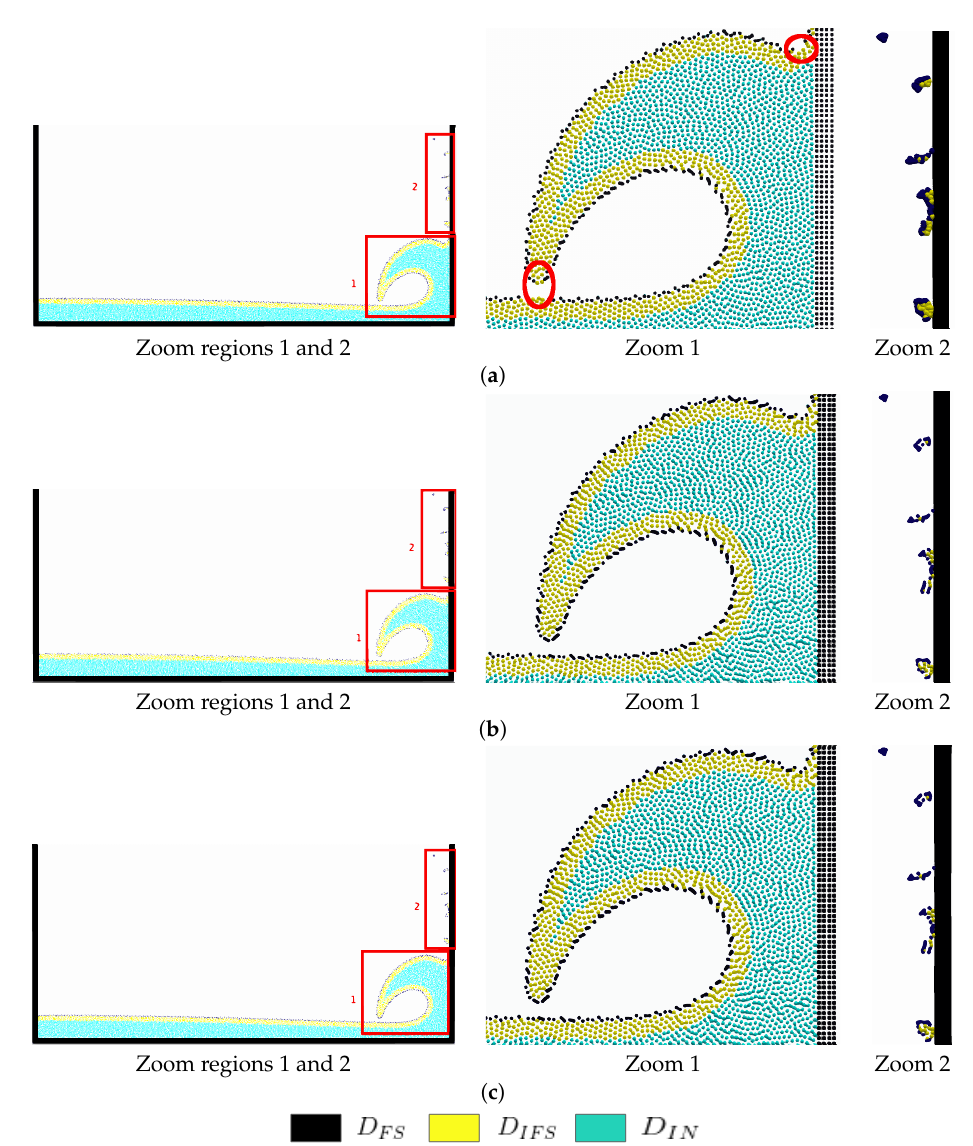
Figure 3. The free surface particles detected for the dam-break example. The free surface particle of the fluid are colored with black color ( D FS ), whereas for the particle colored with yellow and green colors represent respectively, the inner particle near ( D IFS ) and far ( D IN ) from the free surface region. The first row ( a ) shows the results via the method proposed by Marrone et al. [45], while the rows ( b , c ) represent the results using Jandaghian and Shakibaeinia [47] and the present approaches,